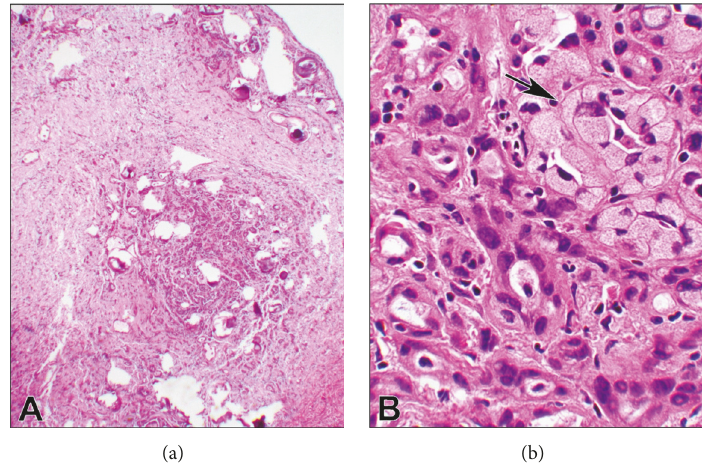
Figure 2: Photomicrographs of the permanent section . ((a), 4x objective) At a low magnification, the lesion shows a fibrous background with embedded tumor cells infiltrating the surrounding stroma. There are many psammoma bodies present throughout the tissue. ((b), 40x objective) At a higher magnification, there are tubular structures with hyperchromatic nuclei infiltrated by the inflammatory cells. Also, clusters of larger cells with foamy cytoplasm (arrow) are